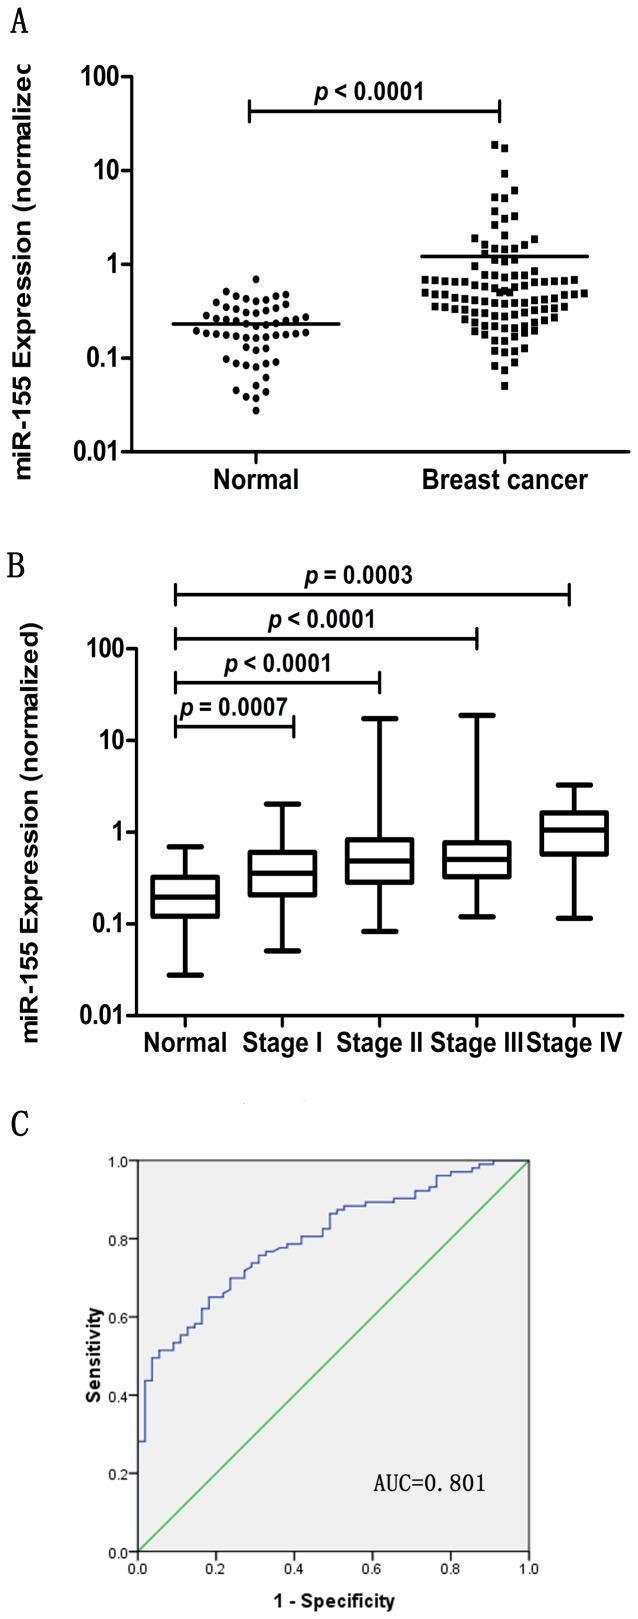
Serum miR-155 levels in normal controls (n = 55) and breast cancer patients (n = 103).The relative expression level of miR-155 was normalized to spiked-in cel-mir-39. The line represents the median value. Statistically significant difference was determined using Mann-Whitney tests. The result revealed a higher level of miR-155 in breast cancer patients (p<0.001) (A). Box plot of serum miR-155 expression levels across stages. The boxes indicate the 25th and 75th percentiles and the bold lines represent the median values. The relative expression levels of target miRNA were normalized to spiked-in cel-mir-39. Statistically significant differences were determined using Mann-Whitney tests or Kruskal-Wallis tests (B). Receiver operating characteristics (ROC) curve analysis for the diagnostic value of miR-155. The AUC (the areas under the ROC curve) was 0.801 (95% CI: 0.734 to 0.868) (C).